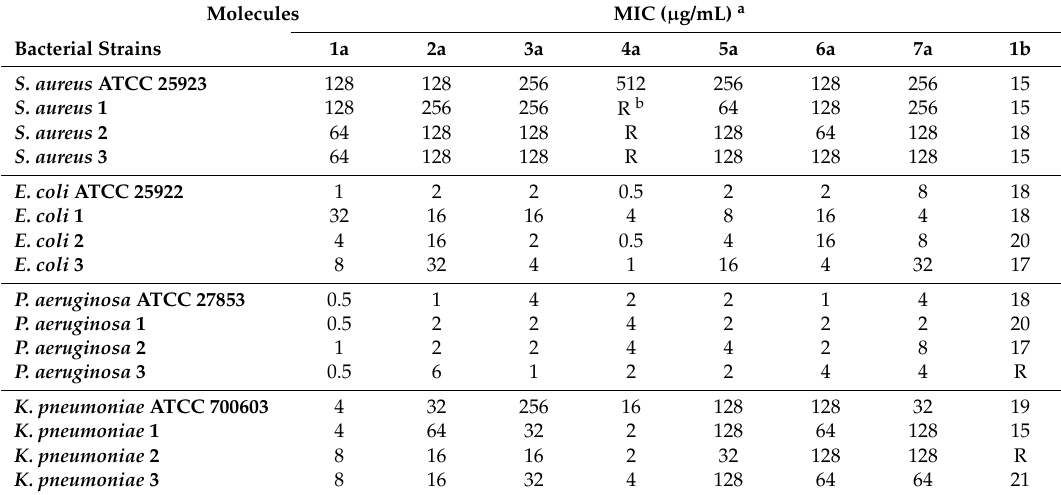
Table 5. Minimum inhibitory concentrations (MICs) of the sulfamidocarbonyloxyphosphonate derivatives 1a – 7a and 1b toward Gram-positive and Gram-negative